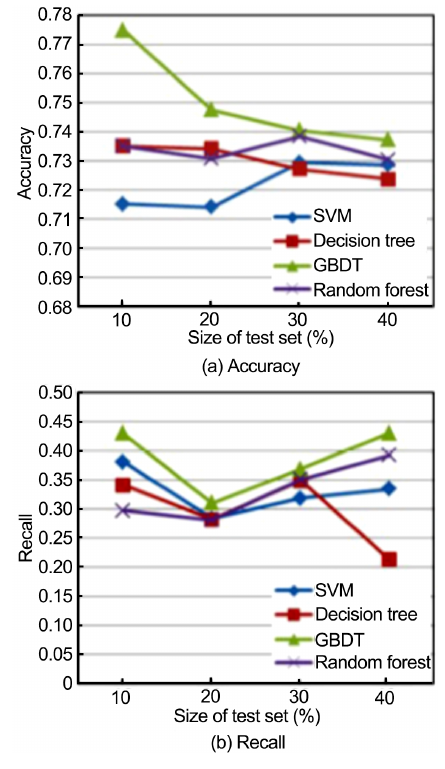
Fig. 7 Accuracy and recall of the four-layer model.